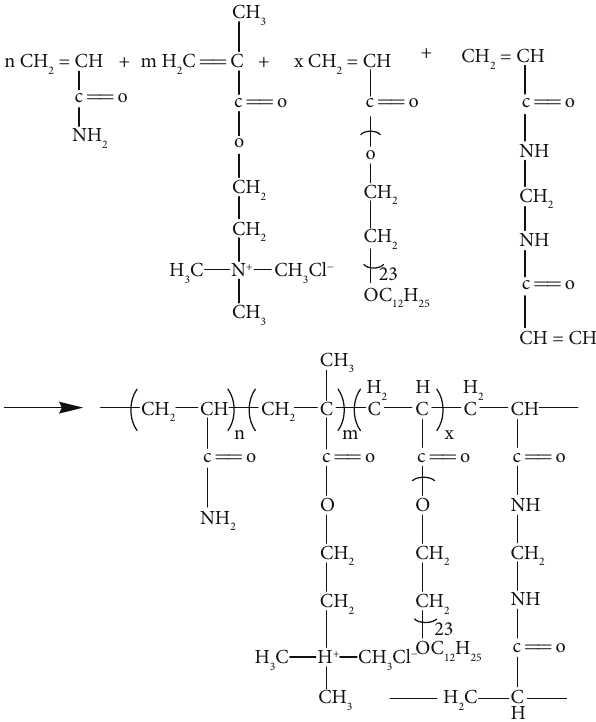
Figure 1: Reaction schemes and molecular structures of monomers and hydrophobical copolymer